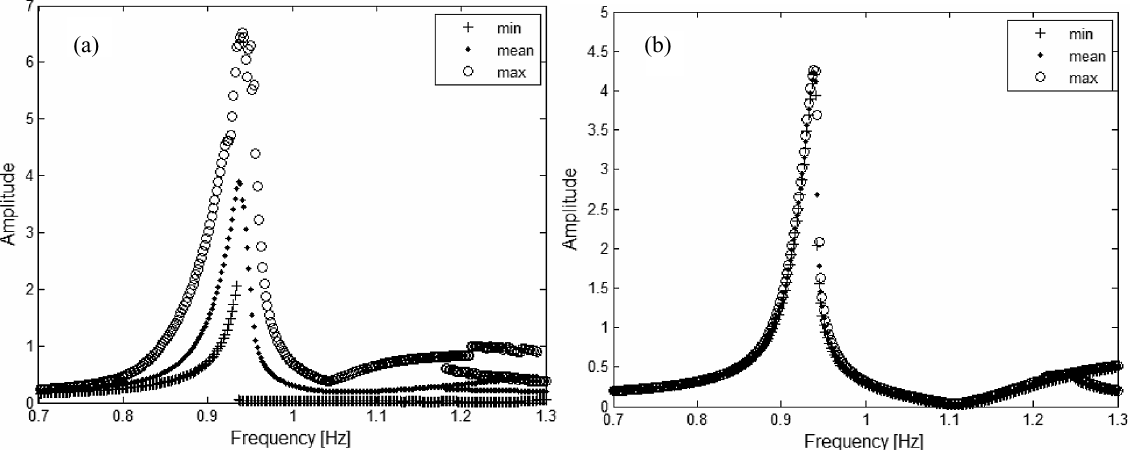
Fig. 12. Envelopes of responses for deterministic (a) and robust (b) optimal